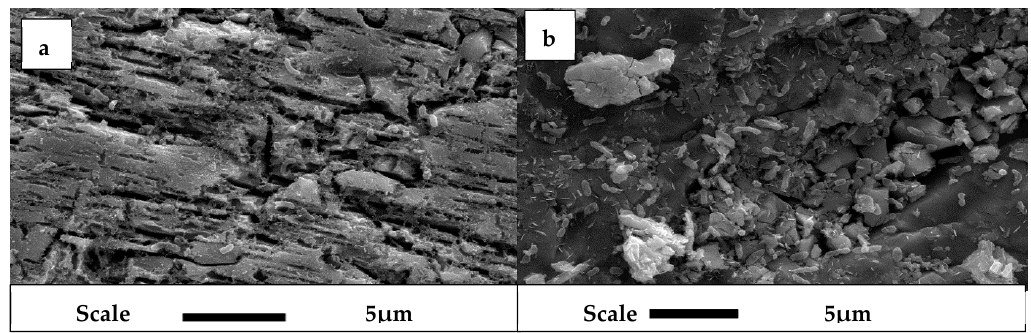
Figure 4. SEM image of ( a ) bacterial attachment to Py (1200× magnification) and ( b ) Cp (1000× magnification) at 168 h exposure to L.f.